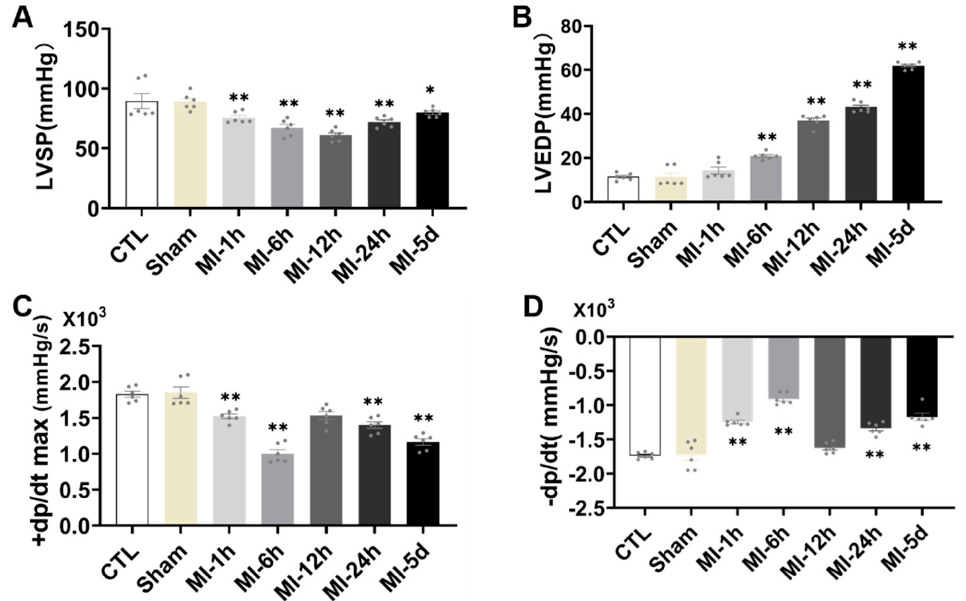
Figure 5. Tests of myocardial function after MI. The cardiac hemodynamic parameters measured included systolic and diastolic function of the left ventricle measured with ( A ) LVSP, ( B ) LVEDP, ( C ) +dp/dt, maximum pressure increasing rate, and ( D ) − dp/dt, maximum pressure decreasing rate ( n = 6.7). Values presented are the means ± SEM. CTL, normal control; sham; MI-1 h, 1 h after myocardial infarction; MI-6 h, 6 h after myocardial infarction; MI-12 h, 12 h after myocardial infarction; MI-24 h, 24 h after myocardial infarction; MI-5d, 5 days after myocardial infarction (* p < 0.05, ** p < 0.01 vs. sham).